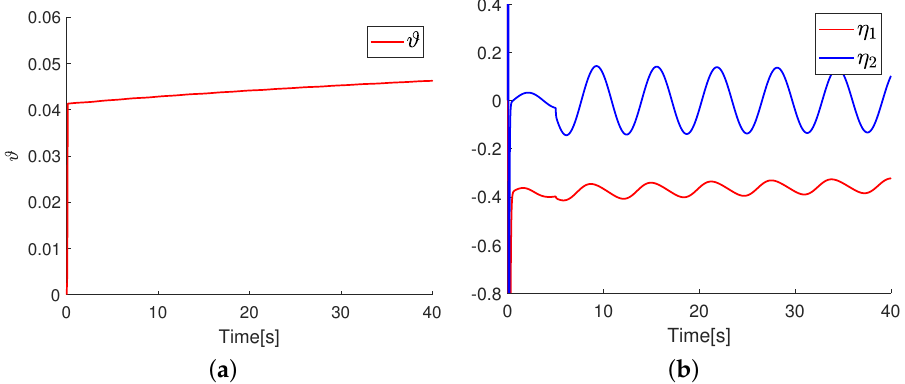
Figure 4. The variation tendencies of the parameters ϑ and η . ( a ) The value of the parameter ϑ . ( b ) The value of the parameter η